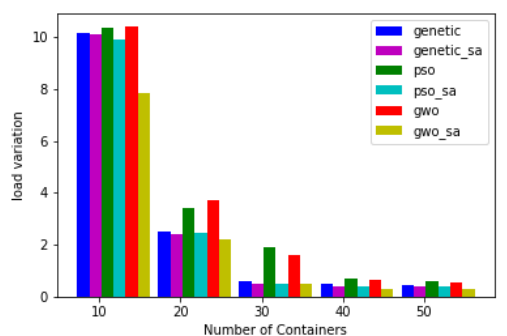
Figure 9. Makespan with 1000 tasks.